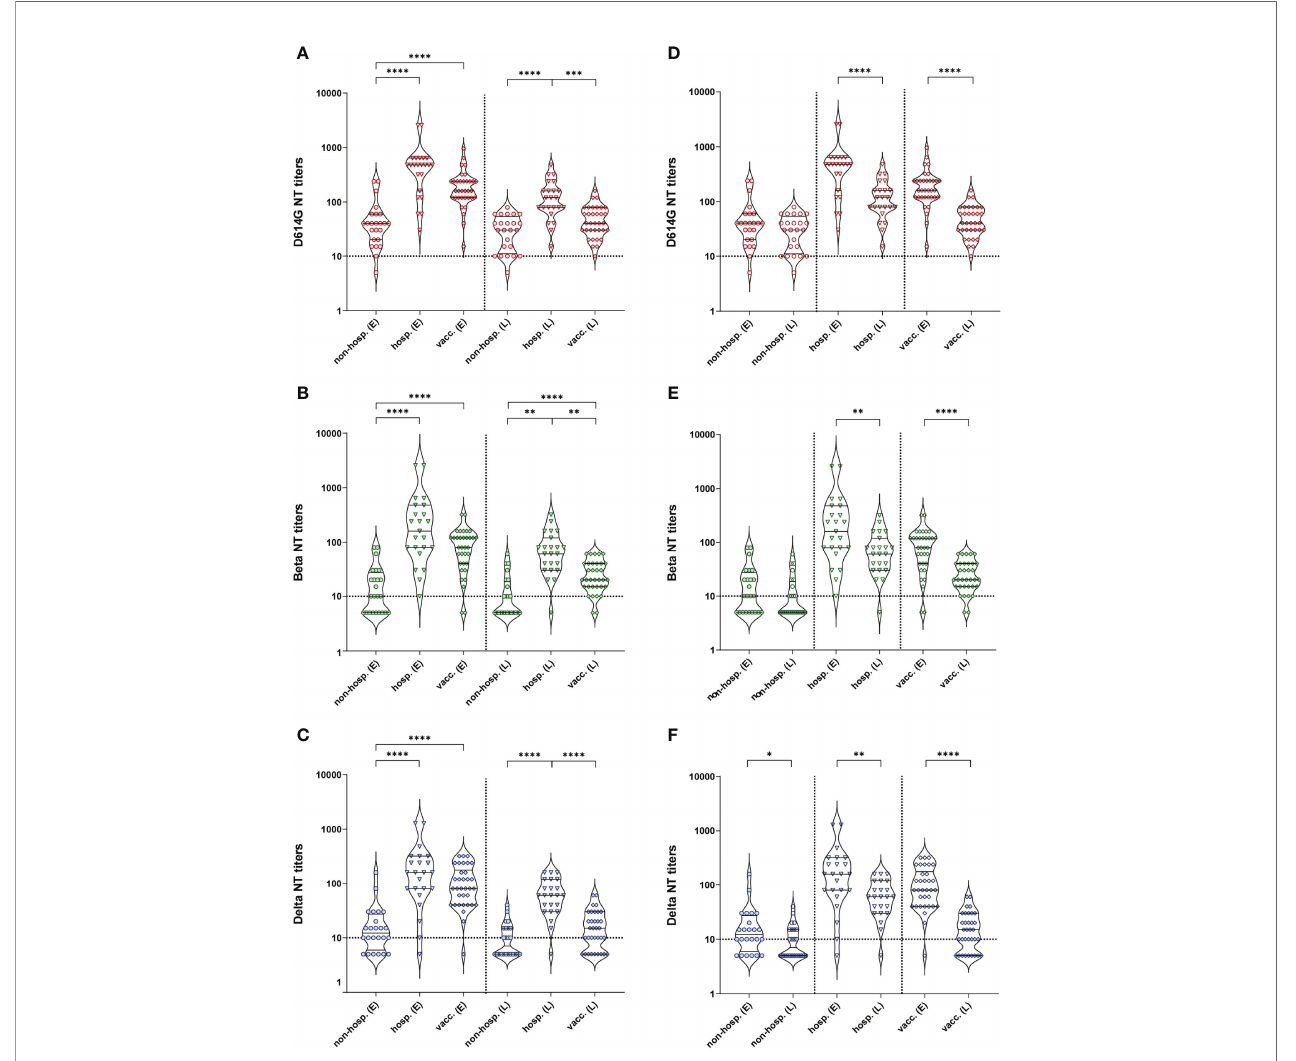
FIGURE 2 | Neutralizing antibody titers against an ancestral D614G virus strain and the two VOCs Beta and Delta after infection (non-hospitalized and hospitalized patients) and two doses of the mRNA vaccine BNT162b2. (A – C) Comparison between cohorts. (D – F) Graphs represent the same data as in (A – C) , but regrouped according to time points of sample collection. (A, D) D614G virus NT, (B, E) Beta VOC NT, (C, F) Delta VOC NT. Early samples (E) were taken approximately three weeks after disease onset or the second vaccine dose; late samples (L) approximately six months after disease onset or the second vaccine dose. Bars within the violin plots indicate the median with interquartile range, the dotted horizontal line the cut-off of the assay. Statistical analysis was performed by Kruskal-Wallis test and Dunn ’ s multiple comparisons post hoc test (A – C) or Mann-Whitney test (D – F) . Asterisks indicate statistical signi fi cance: (*) = P ≤ 0.05, (**) = P ≤ 0.01, (***) = P ≤ 0.001, (****) = P ≤ 0.0001. non-hosp., non-hospitalized patients; hosp., hospitalized patients; vacc.,